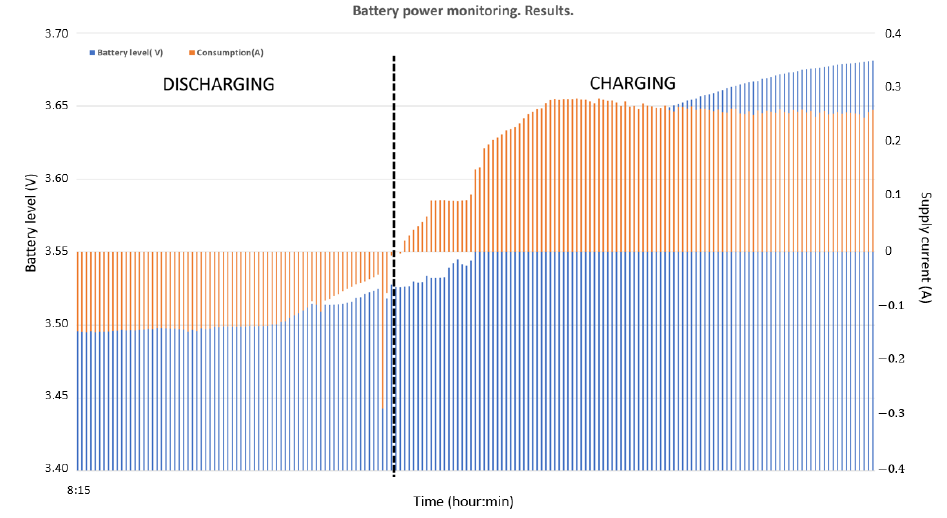
Figure 12. Example of battery charge and discharge time periods.